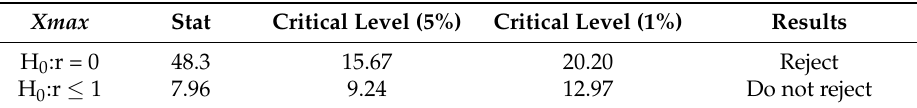
Table 4. Cointegration tests: